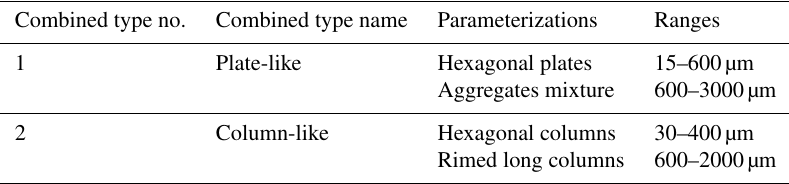
Table A2. Combined particles types used in the context of this work. Combined type